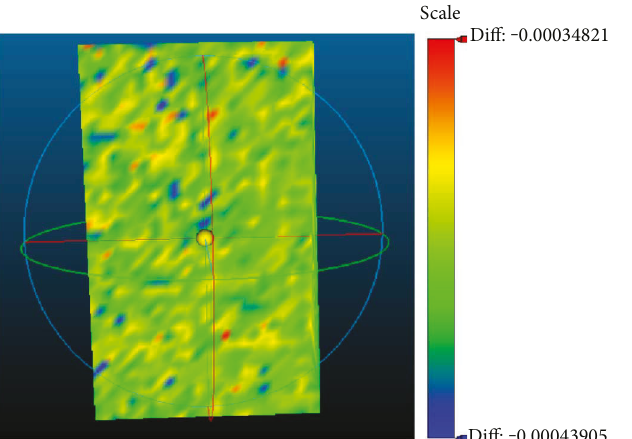
Figure 18: A di ff erence map between two images taken continuously with no movement. In the scale of the di ff erence, we can see that the maximum di ff erence between the two images is 0.00035 pixel, which is signi fi cantly below 0.1 millimeter; this result demonstrates the algorithm ’ s